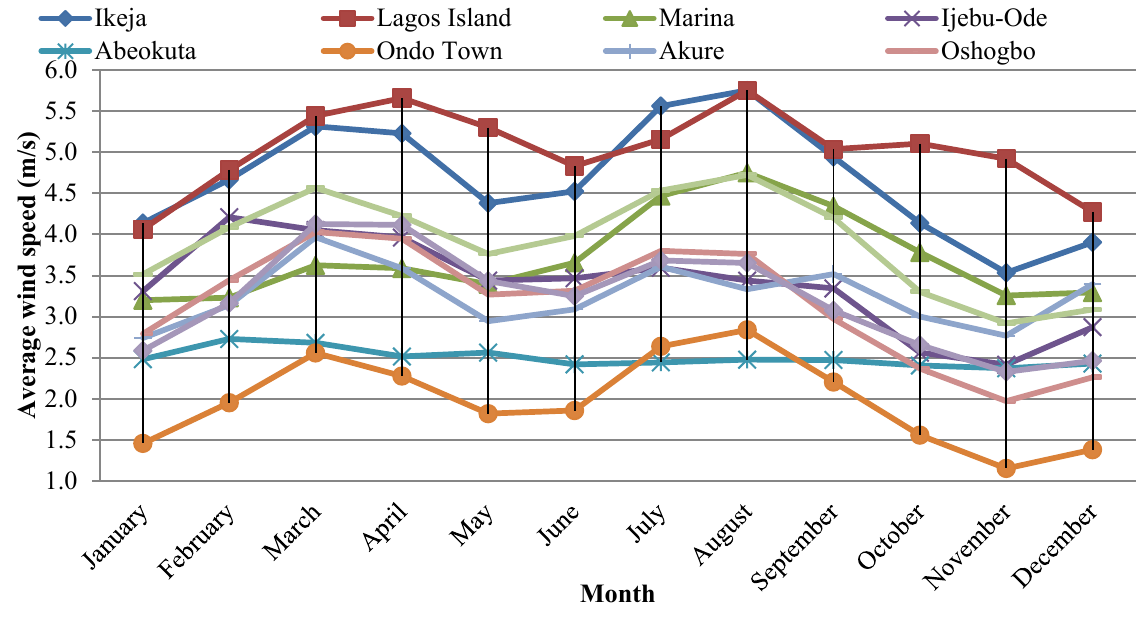
Figure 2. 24 years’ average monthly wind speeds distributions across the